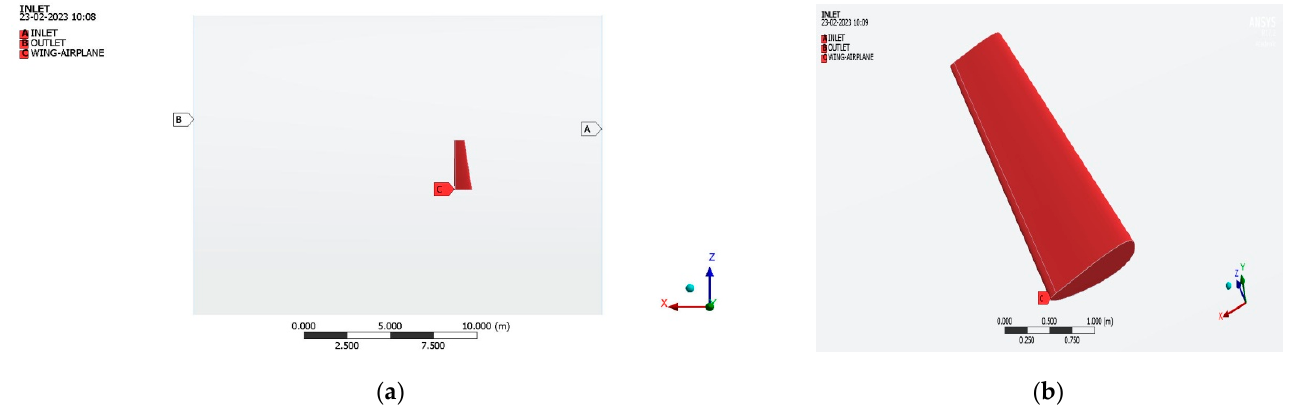
Figure 10. Initial naming conditions of an airplane wing, CFD Analysis. ( a ) A systematic representation of imposed naming on entire CFD domain. ( b ) A systematic projection of imposed naming on airplane wing–zoomed view.